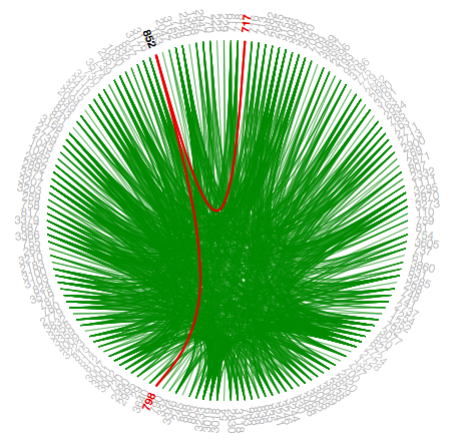
Figure 14. Represents the path highlights for the selected